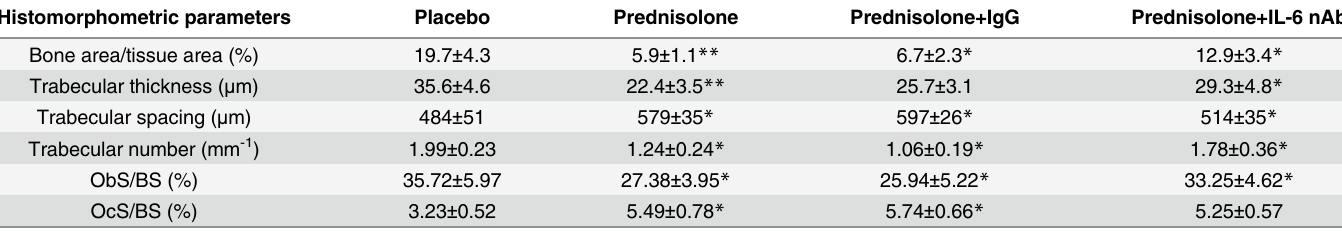
Table 4. Vertebral cancellous bone histomorphometry analysis in osteoporotic mice with and without IL-6 nAb administration. ObS: Osteoblast surface, OcS: Osteoclast surface, BS: bone surface. Data shown are the mean ± SD. There are ten animals per group. Histomorphometric